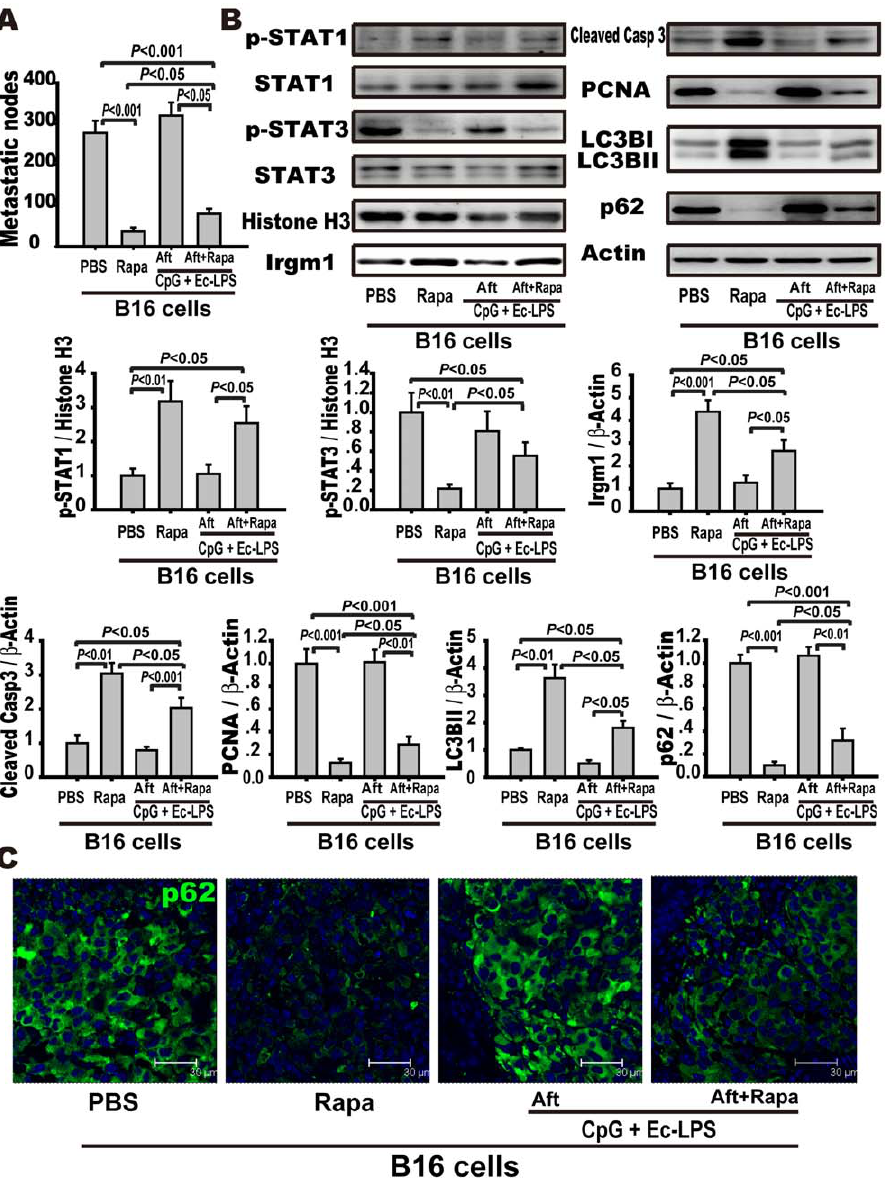
Figure 5. Augmentation of autophagy with rapamycin protects against tumor metastasis. C57BL/6 mice were injected with B16-F10 melanoma cells (5 6 10 5 ) and were humanely sacrificed 14 days after inoculation of tumor cells. Mice were intraperitoneally administered with the TLR4/TLR9 agonist complex (dosage and frequency as in the legend of Fig. 1) with or without rapamycin (10 mg/kg, once a day) after tumor cell inoculation. (A) Rapamycin protects against metastasis. Metastatic nodules were counted and data are presented as the mean 6 S.E. (n=10). (B) Rapamycin activates autophagy and regulates STAT1/3 signaling. The expression of STAT1/3 singling and autophagy-related molecules in the lung tissue was detected by Western blot. The lungs were excised and the cytoplasmic and nuclear fractions were extracted as described in the Methods. The expression of p-STAT1, STAT1, p-STAT3, STAT3, and histone H3 in nucleic extracts and IRGM1, LC3B, cleaved caspase-3, P62, PCNA, and b -actin in the cytoplasm were detected with Western blotting. Left panel is representative western blots and right panels are summary results. Data are presented as the mean 6 S.E. of 5 mice per group. (C) Rapamycin treatment decreases p62 accumulation in the lung tissue. Representative immunofluorescence microphotographs were presented to show p62 accumulation in melanoma cells. Lung sections were stained for p62 (green) and DAPI (blue). Scale bar: 30 m m.